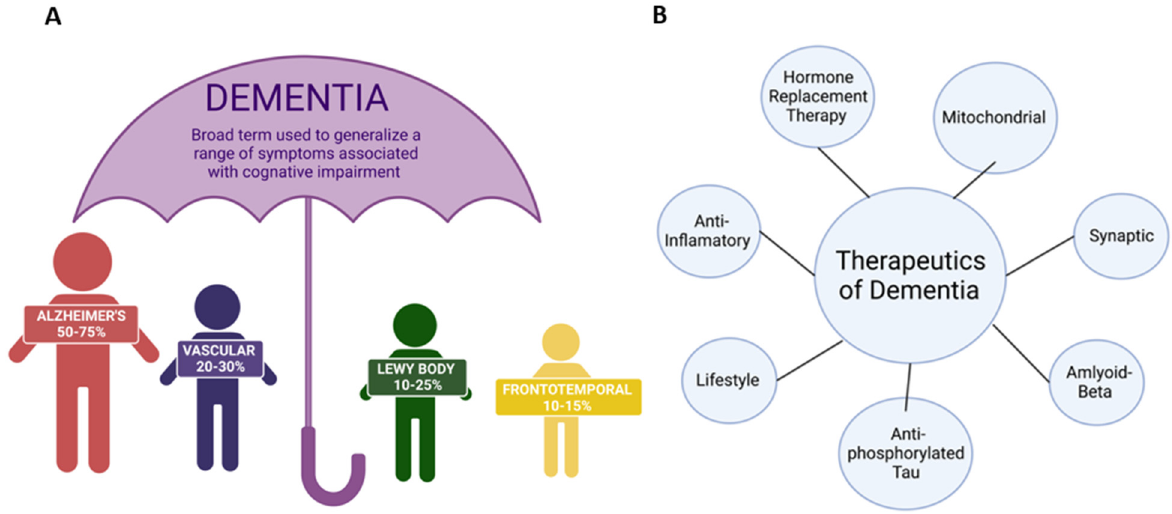
Figure 1. Types and therapeutics of dementia. ( A ) The significant types of dementia are Alzheimer’s disease, Lewy body dementia, Vascular dementia, and frontotemporal dementia. ( B ) Possible thera- peutic strategies to treat dementia.